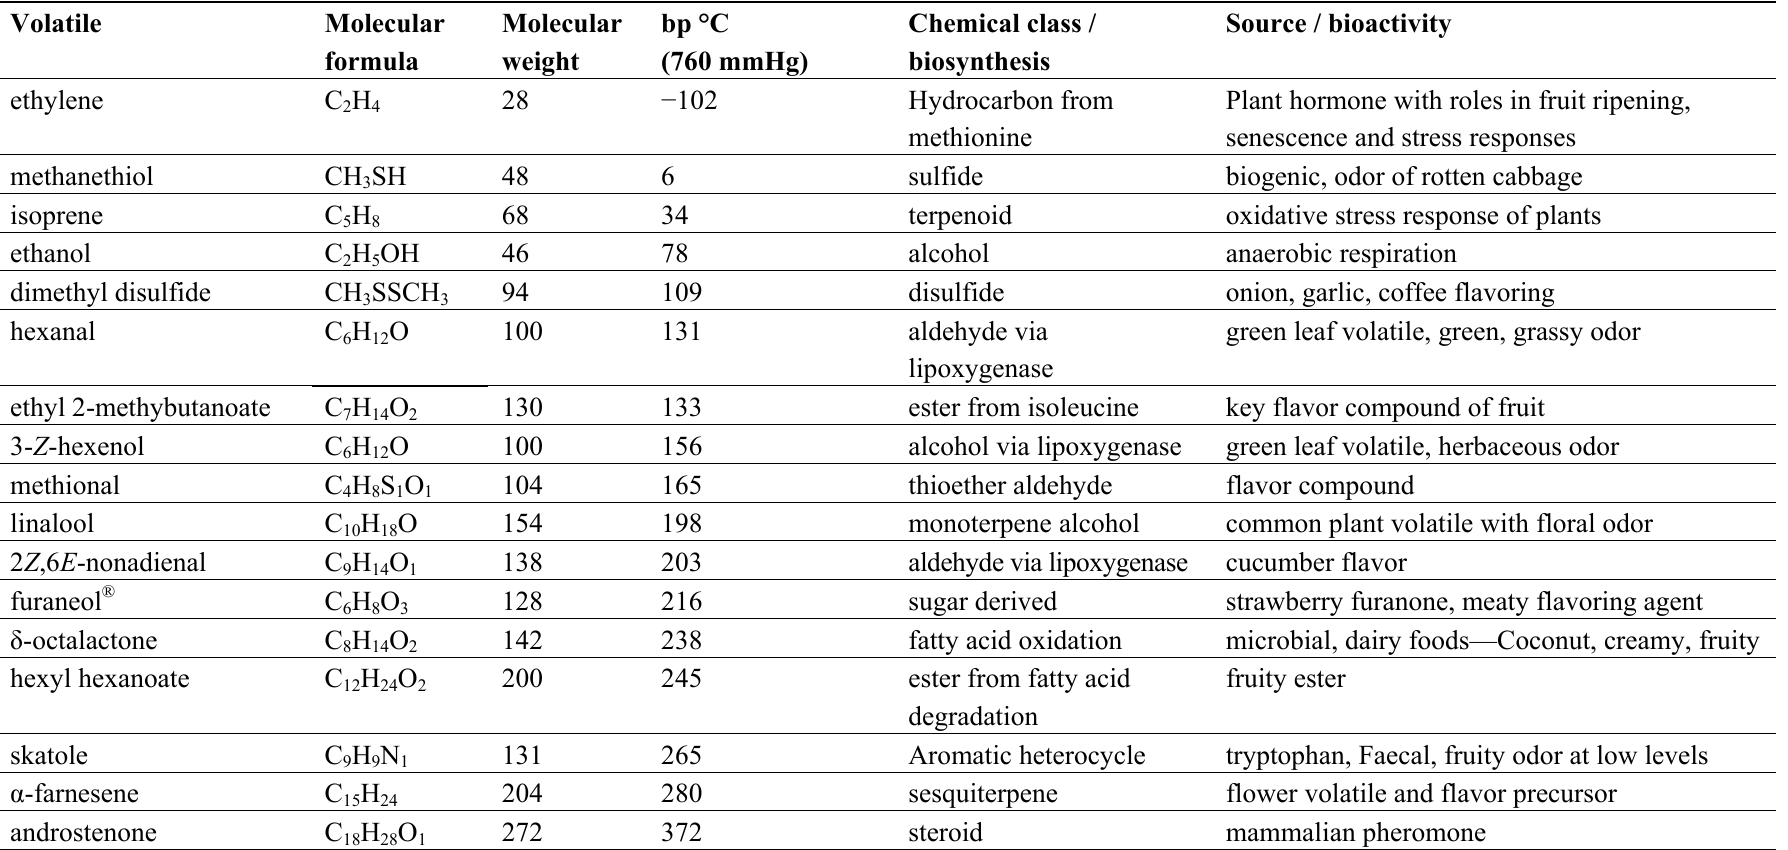
Table 1. A selection of volatile metabolites arranged in order of increasing boiling point and chosen to illustrate the different physical and chemical properties of this class of